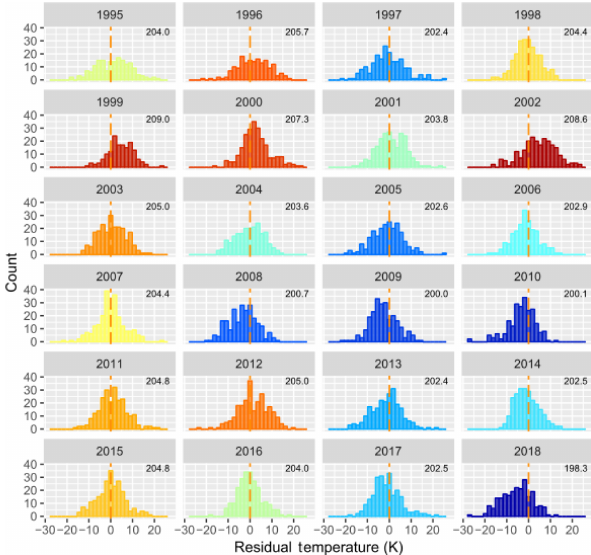
Figure 4. Histograms of nightly mean residual temperatures show- ing the distribution about the mean winter temperature (given in top right corner) coloured from red (warmest year: 1999) to blue (cold- est year: 2018).